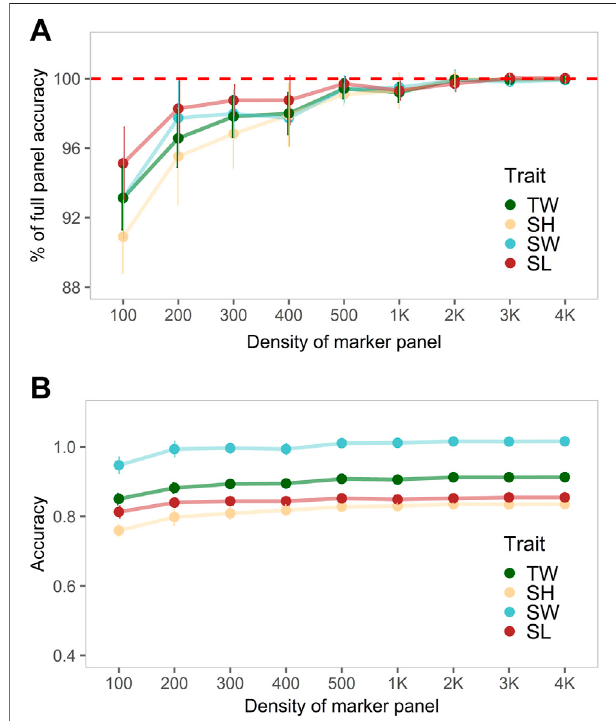
FIGURE 4 | Evaluation of the effect of SNP density on genomic predictions of growth related traits in a European fl at oyster population. (A) Percentage of the maximum genomic prediction accuracy achieved using different lower density SNP panels. Values were calculated by dividing the mean accuracy (averaged over ten replicates) estimated at each nominal SNP density bytheaccuracyobtained usingthe fullSNP dataset. (B) Average genomic prediction accuracy values obtained for oyster growth traits at different panel